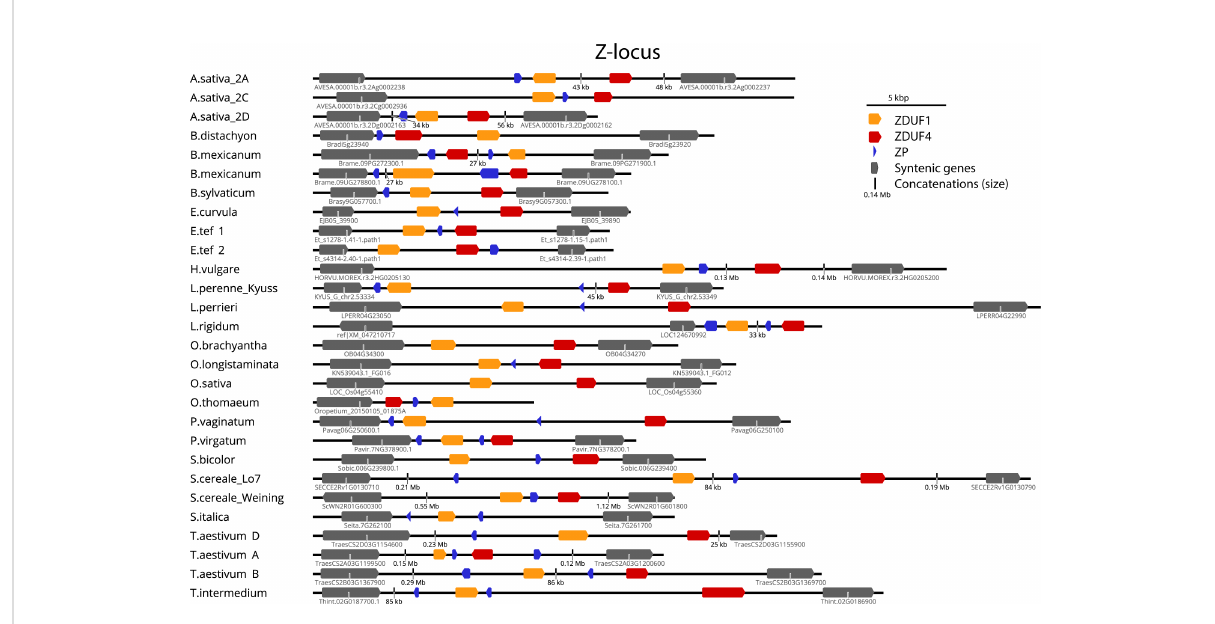
FIGURE 4 Structure of the Z-locus in different grass subfamilies. Structure of Z-loci identi fi ed in other species. In all cases, a Glycerol kinase (GK) is on the left, and Ubiquitin Conjugating Enzyme (UBC) is on the right. Gene identi fi ers are shown for GK and UBC for each genome where available. See Supplementary Dataset S4 for details of